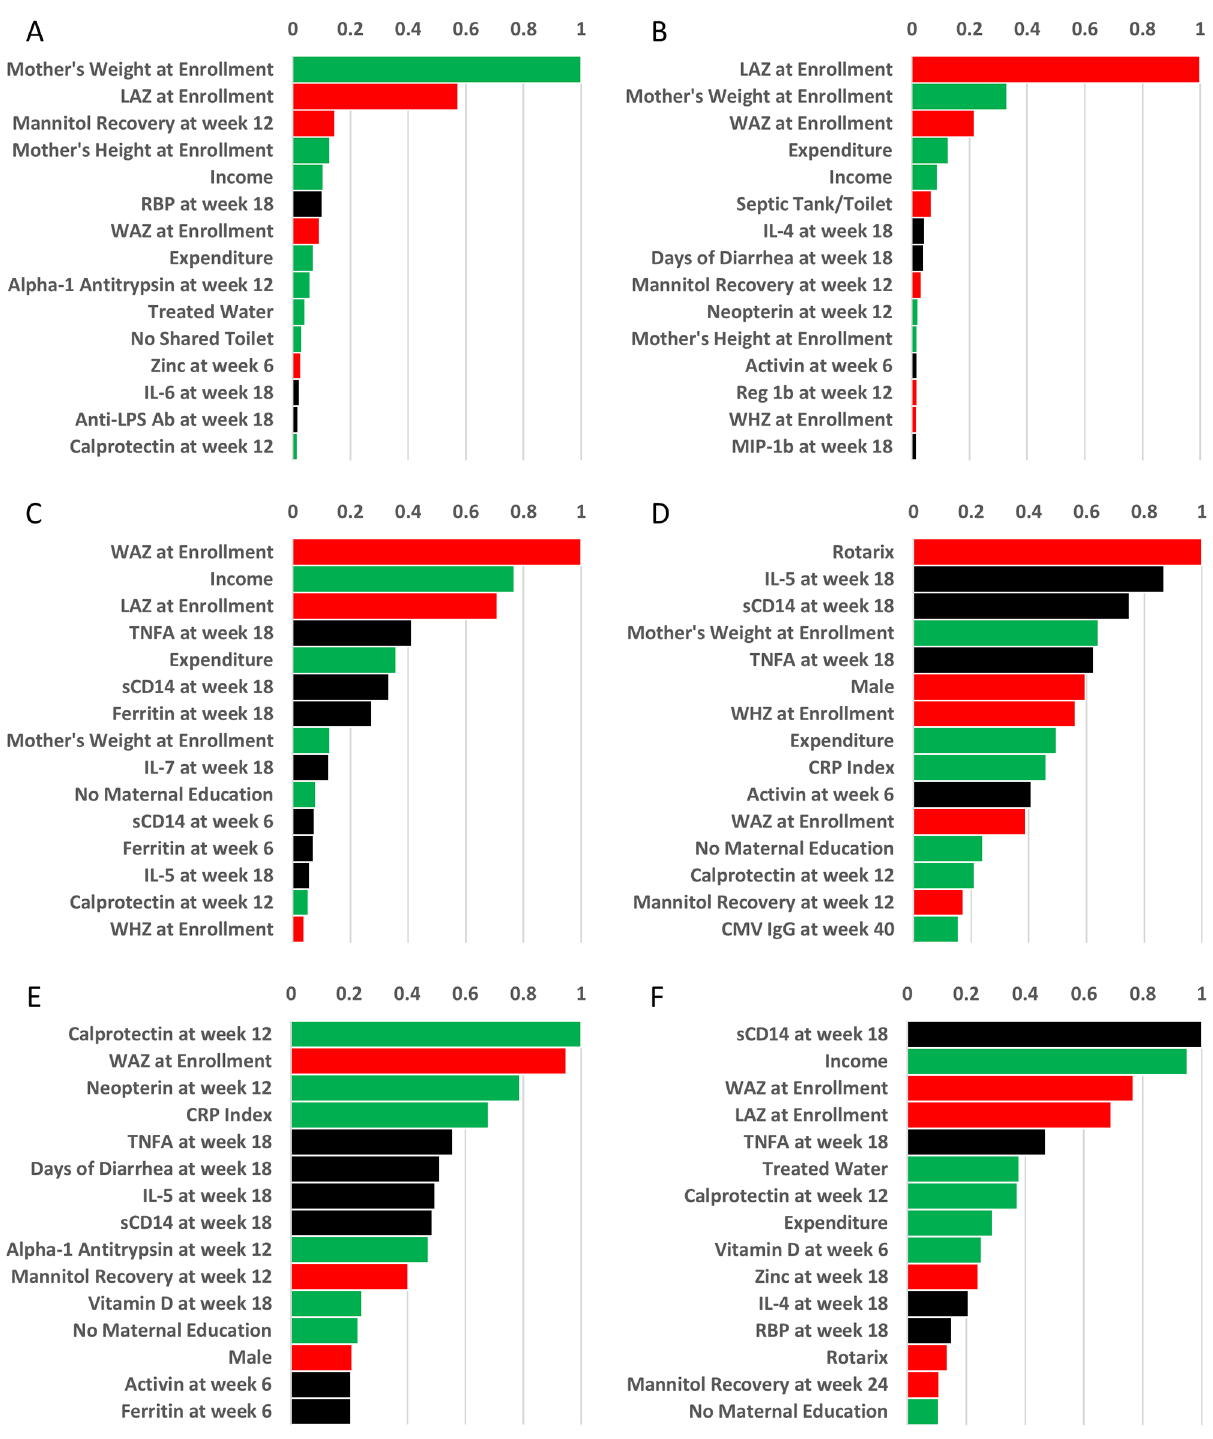
Fig 2. Random forests plots of the top 15 variables selected for linear growth and performance on the Bayley-III scales of infant and Toddler Development. Random forests models were constructed for LAZ at two years (A), the change in LAZ from enrollment to two years (B), and Bayley-III scores at two years of age. The Bayley-III is comprised of 4 components, namely cognitive (C), language (D), motor (E), and social-emotional (F). Color- coding correlates to the three clusters identified when all variables were analyzed using Pearson’s correlation (S1 Fig).